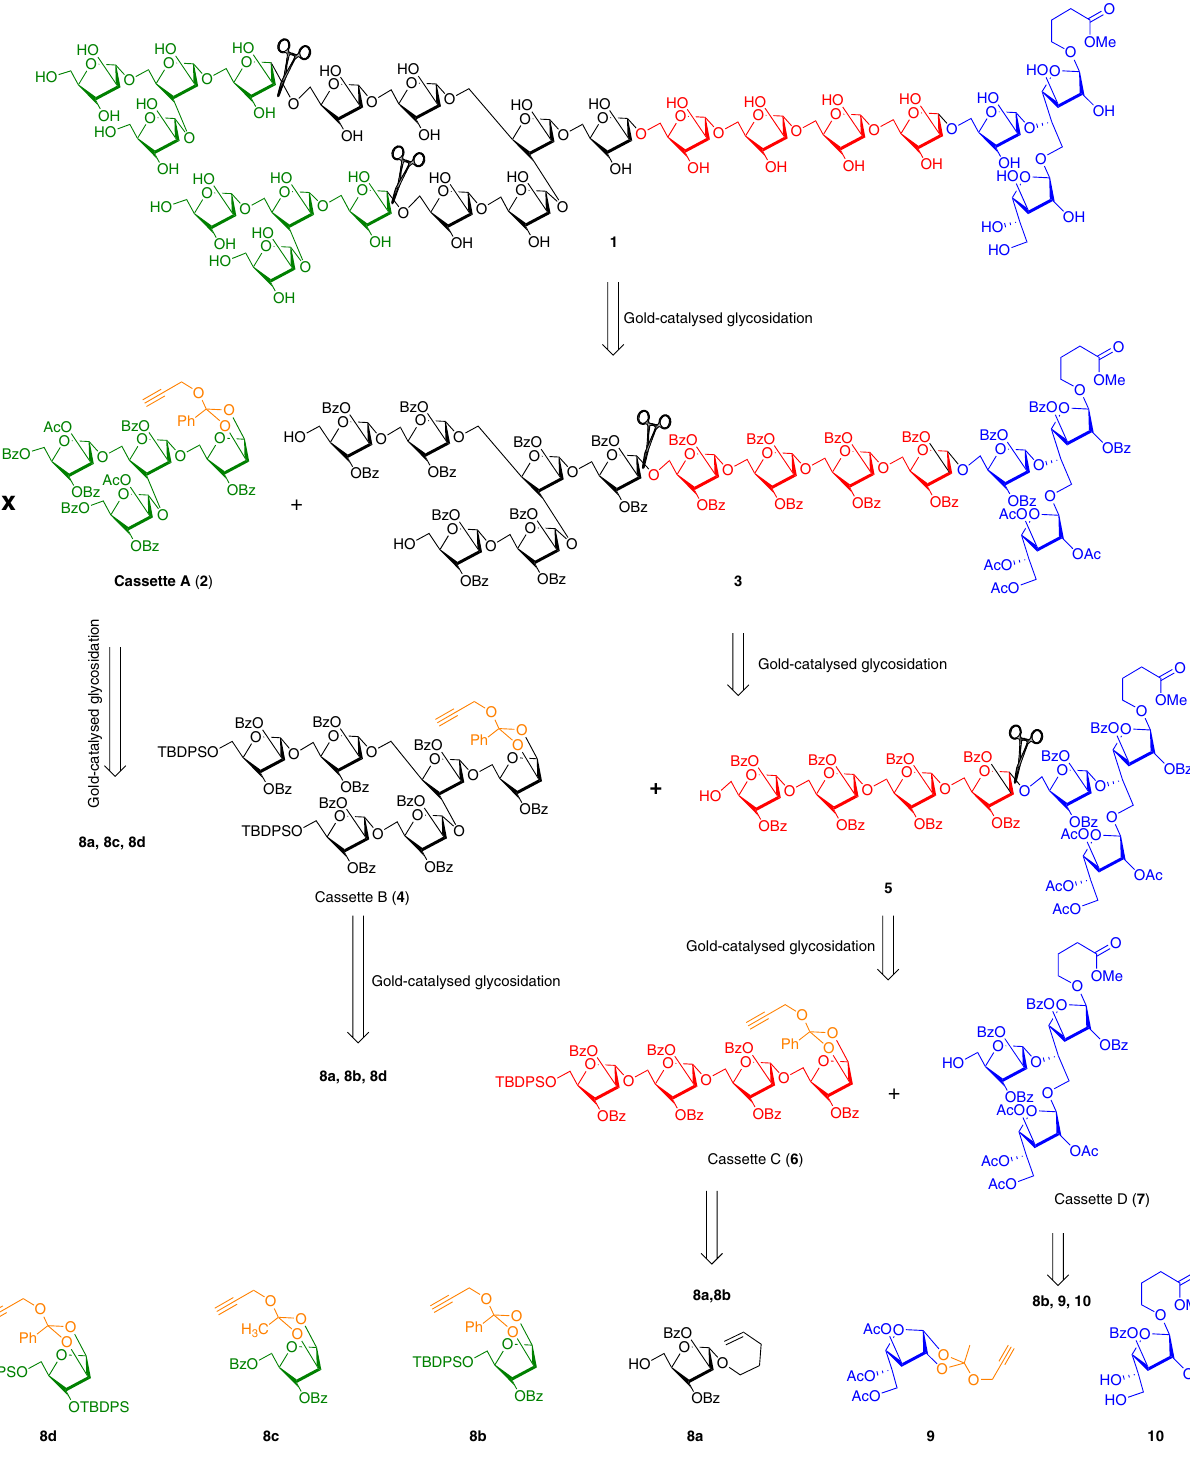
Figure 2 | Retrosynthetic plan for the synthesis of heneicosafuranoside 1. Retrosynthetic analysis shows the assembly of heneicosafuranosyl arabinogalactan ( 1 ) can be synthesized from cassettes A-D which in turn can be obtained from monosaccharides 8a – 8d , 9 and 10 .